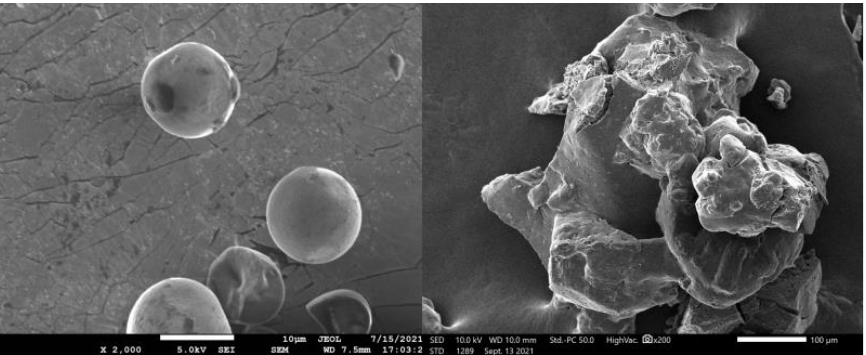
Figure 3. SEM images at 2000× magnification of cassava starch ( left ) and starch laurate, 10 h ( right ).